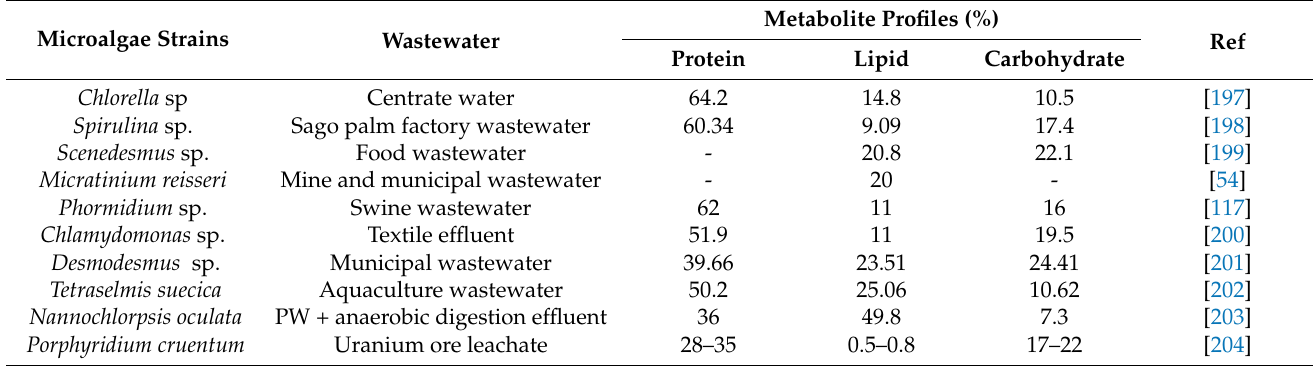
Table 5. The metabolites of wastewater-grown